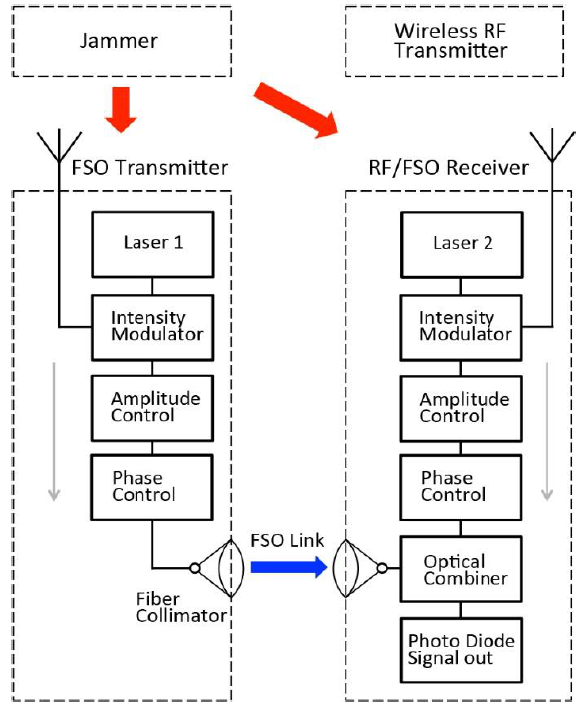
Figure 5. Experimental setup of the anti-jamming system.